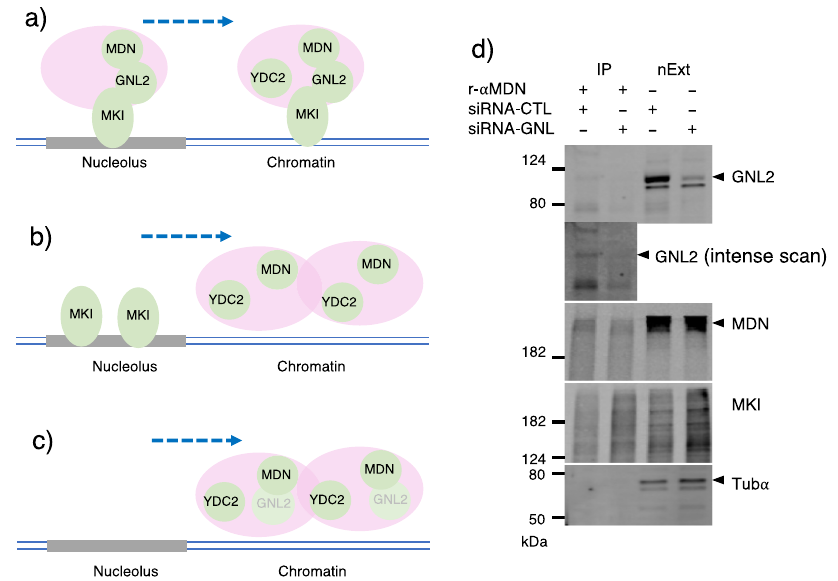
Fig. 5 Migration of nucleolar proteins, MKI67, MDN1, and GNL2. a A model of RNAmetasome network protein migration in HEK293T. Nucleolar proteins with MDN1 are maintained in the nucleolus by binding of MKI67 to the nucleolus periphery chromatin. The MDN1 complex migrates out of the nucleolus and recruits some proteins in the nucleoplasm, such as YTHDC2. b Depletion of GNL2 relaxes the interaction between MKI67 and MDN1 and accelerates migration of the MDN1 complex to the nucleoplasm. c Depletion of MKI67 accelerates migration of the MDN1 complex to the nucleoplasm. d Co-IP of GNL2 and MKI67 with the anti-MDN1 antibody in GNL2 depleted nuclear and the control extracts. The siRNA and the universal negative control siRNA were added at 40